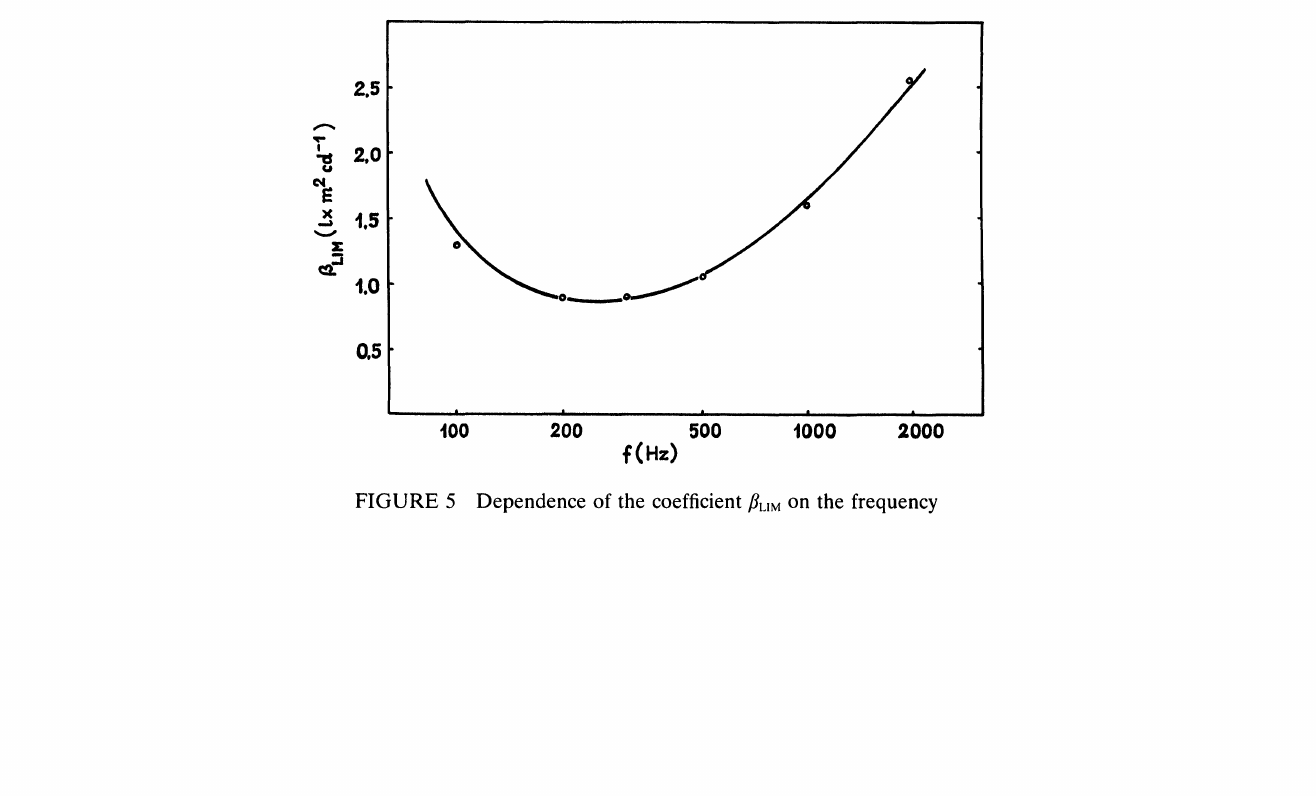
FIGURE 4 Spectral distribution [%] vs. 2 [nm] of the sensitivity of the CdS(Cu, CI) photoconductive layer (curve a) and of the electroluminescence of the ZnS(Cu, CI, Mn) layer (curve b)